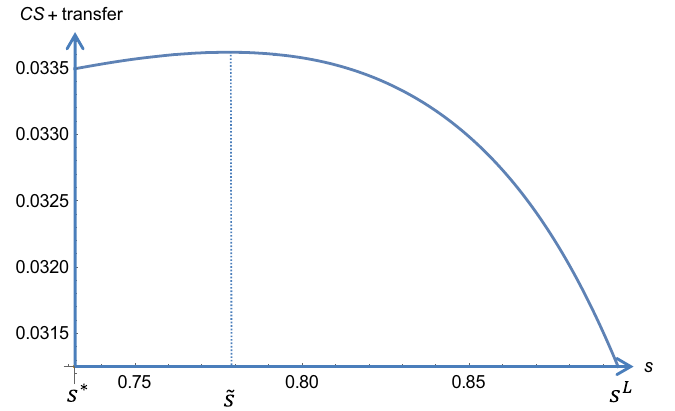
Fig. 10 Consumer surplus of insiders after transfer t , as a function of the size of the buyer group,